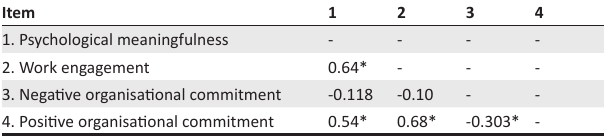
TABLE 2 : Correlation coefficients of the latent variables.